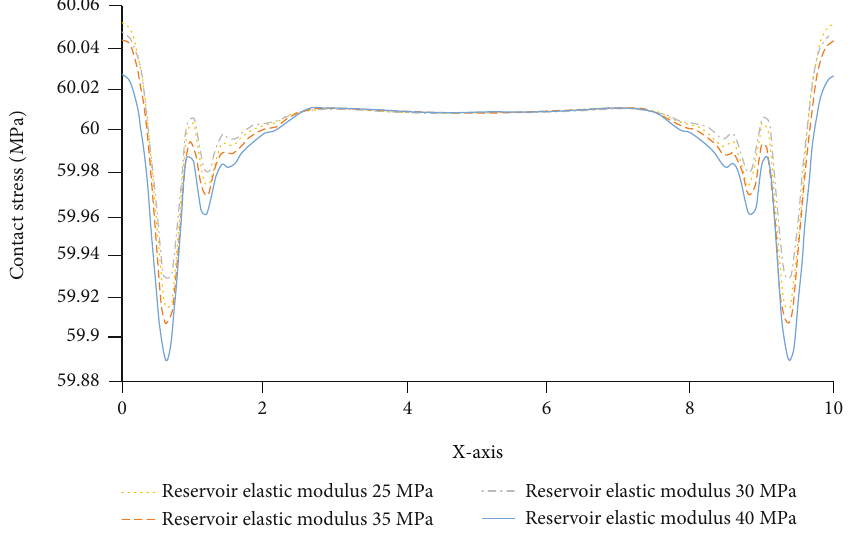
Figure 35: Comparison of contact stress of rock slab under di ff erent elastic moduli (in situ stress 60